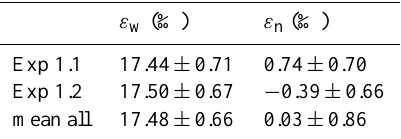
Table 3. Isotopic fractionation factors calculated based on Exp 1 results with Eq. (12) (see text for details). Results presented sepa- rately for Exp 1.1 and 1.2 and mean values for